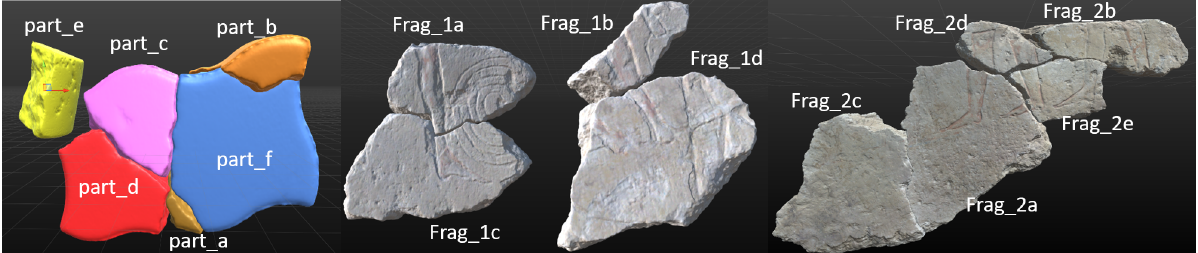
Figure 5: Datasets for experiments after the puzzle is completed.